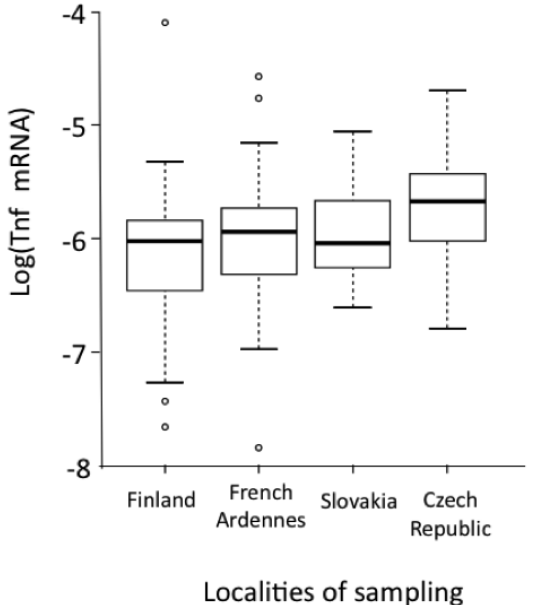
Figure 3. Geographic variations of the levels of Tnf relative expression (see above for detailed formula) detected in bank voles from four European localities [16]. A multiple linear regression with selection model procedure was performed; locality was the only significant effect detected ( F = 5.204; p = 0.002). Boxes represent the first and third 3,132 quartiles of the distribution. Horizontal black lines correspond to medians. The vertical dashed lines correspond to 1.5 times the interquartile range. The circles represent the values superior and inferior to 1.5 times the interquartile